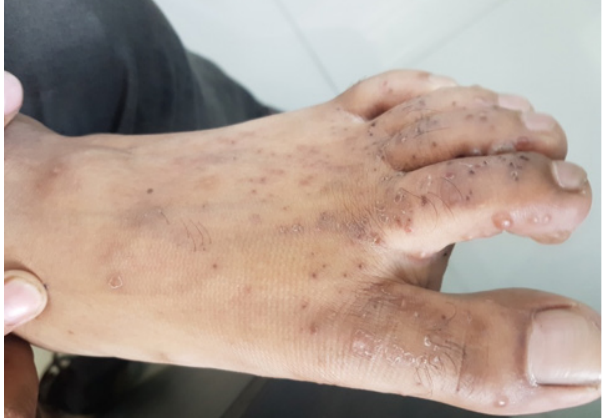
Figure 1: pompholyx in hotel worker. (Permission was obtained from patient to display photo image)